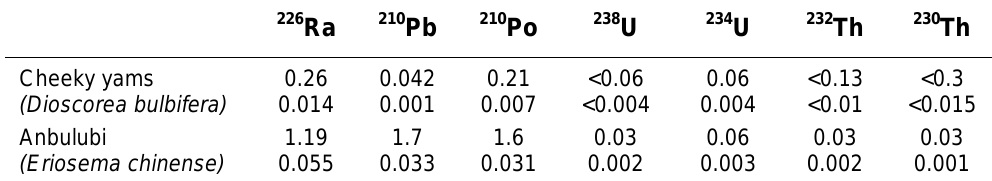
Activity Concentrations (Above, Bq/kg -1 Fresh Weight) and CRs (Below, Fresh